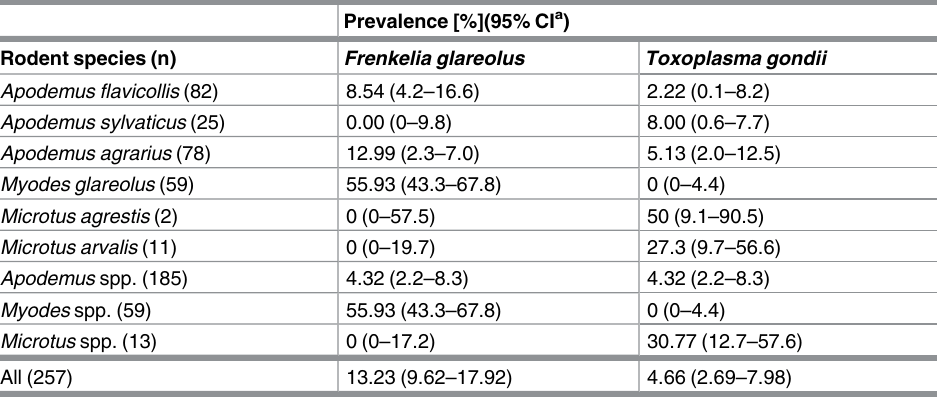
Table 2. Prevalence rates of Coccidia in small